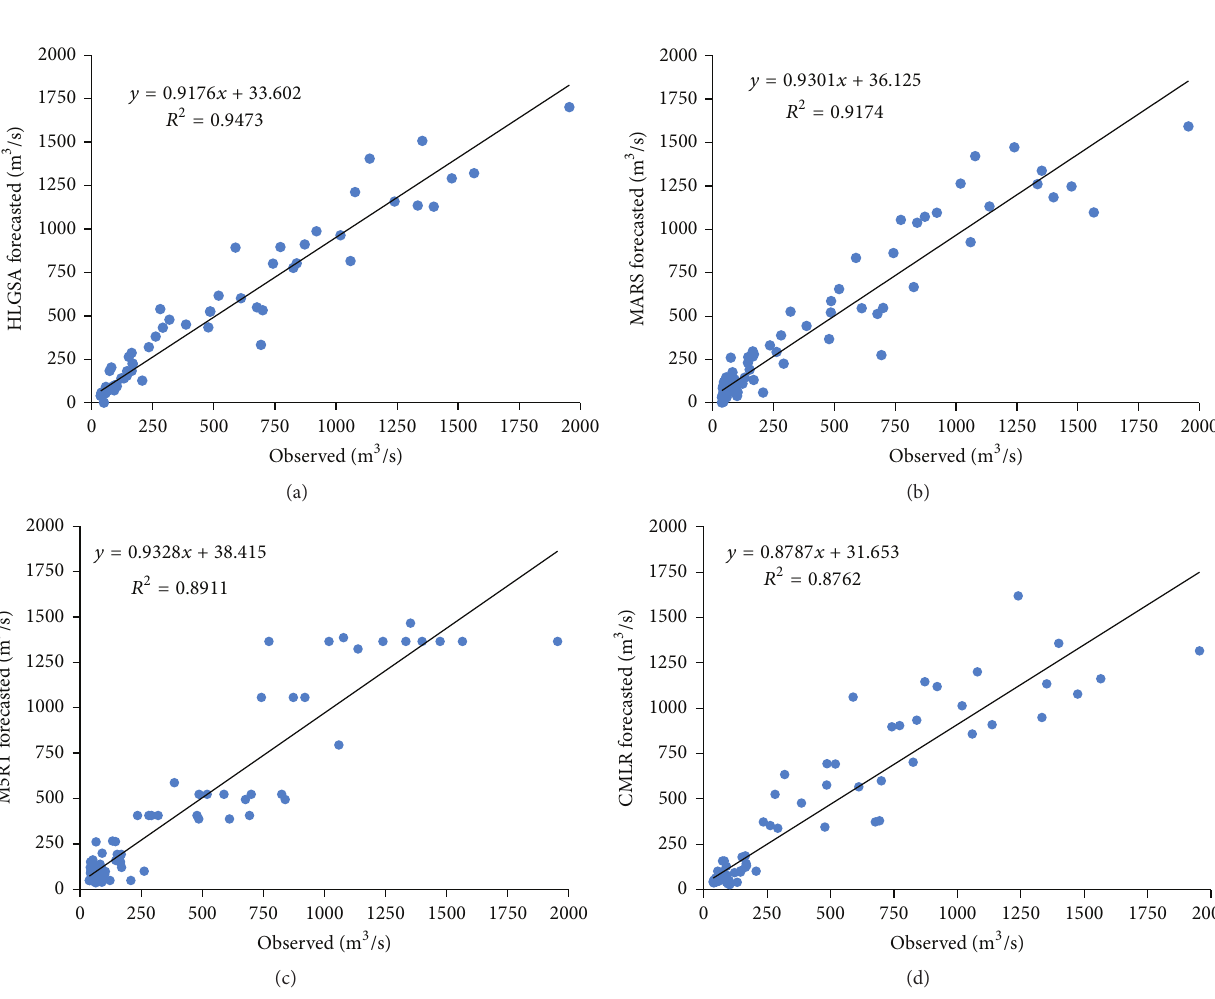
methods and report that the HLGSA performs better than the other methods. However, in contrast to Astore, here the